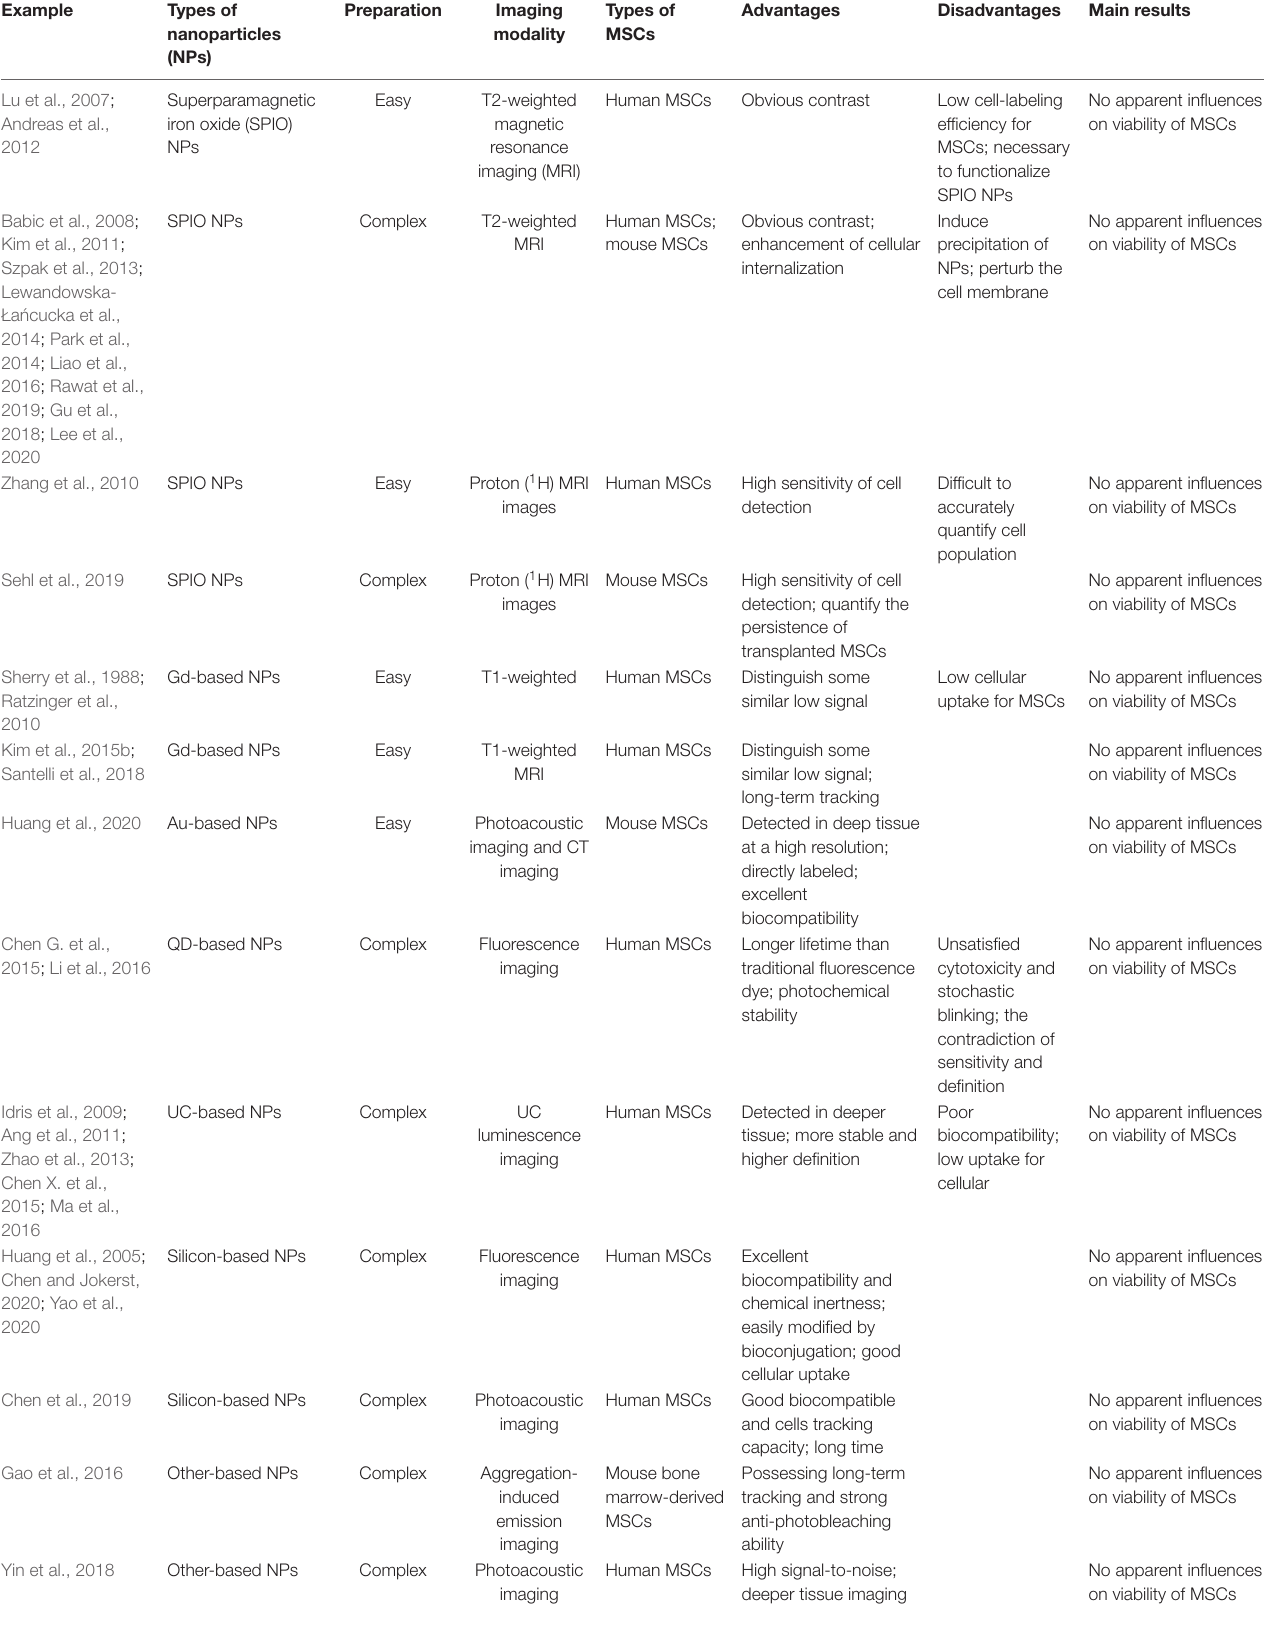
TABLE 1 | Comparison between nanoparticles for tracking mesenchymal stem cells